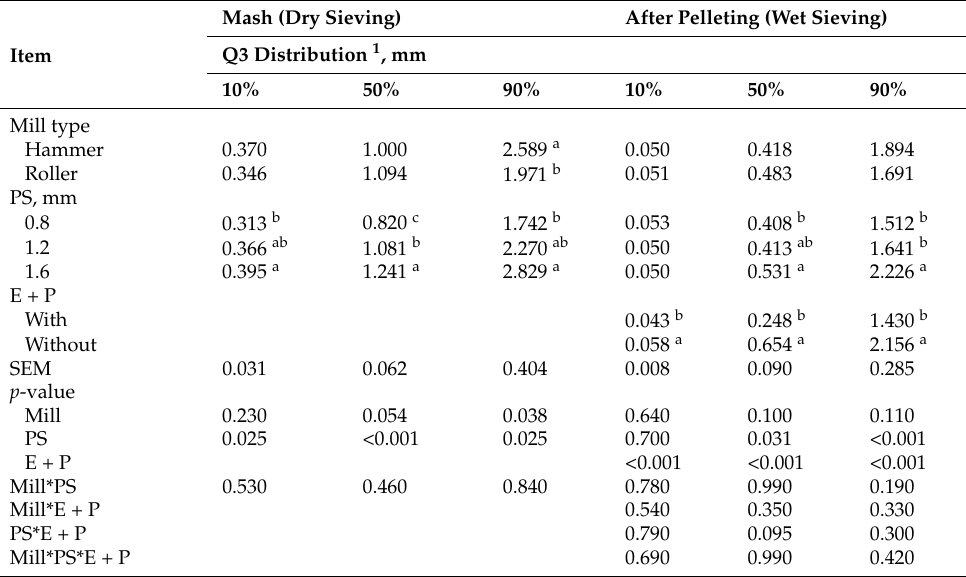
Table 2. Estimated particle size cumulative distribution (mm) of broiler diets ground using two types of mill at three particle sizes (PS), submitted to conditioning with or without expander (E + P) prior to pelleting, and the quality of resulting pellets.